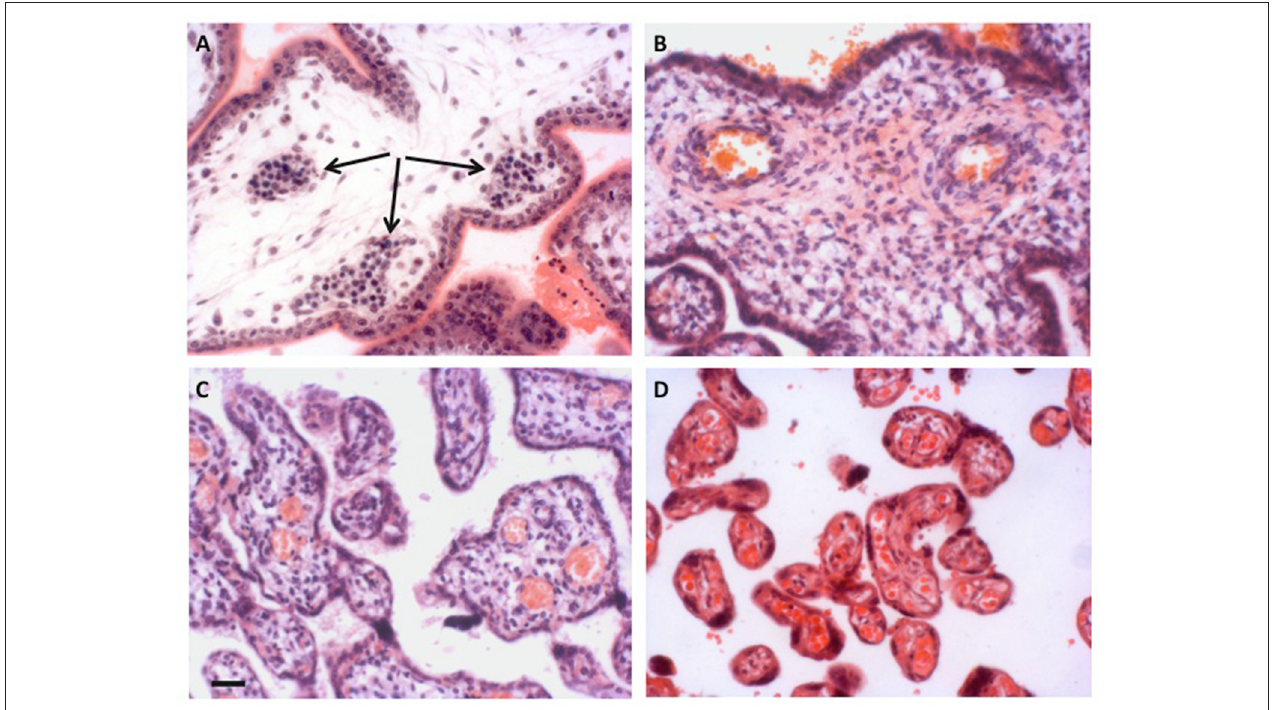
FIGURE 2 | Development of the placental vasculature. (A) Placental villi of 6 weeks gestational age prior to onset of the chorionic circulation, showing the presence of nucleated erythrocytes in the developing fetal capillaries (arrowed). (B) Villi at 14 weeks gestational age showing the presence of non-nucleated erythrocytes in the larger vessels within the stromal core, indicative of onset of the chorionic circulation. (C) Villi of 27 weeks gestational age. By now the smaller peripheral villi are being elaborated. (D) Villi of 40 weeks gestational age showing well vascularized terminal villi. Scale bar for all images = 50 µ m. Stain; haematoxylin and eosin for all.